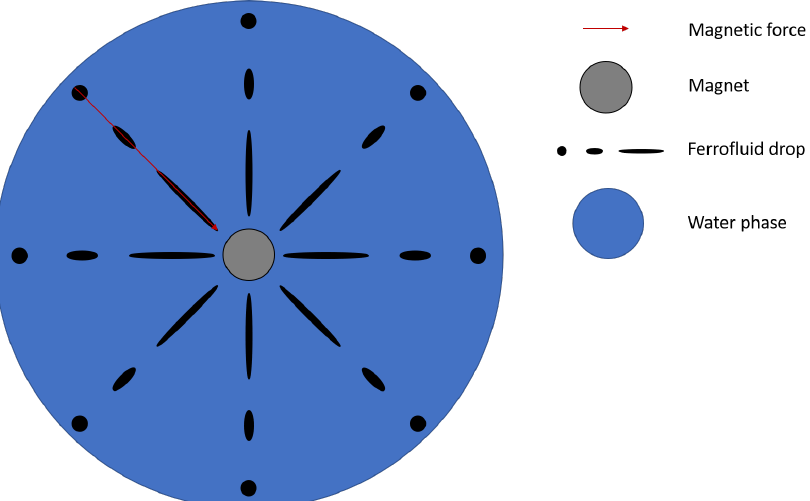
Figure 1. Sketch of the magnetic separator unit proposed by Zahn et al. [6], consisting of a single magnetic rod. In this top view, it is represented how the gradient of magnetic field generates a magnetic force attracting the ferrofluid droplets towards the magnet. As the surrounding water and air move freely, the ferrofluid drop is undergone to a shear-free extensional